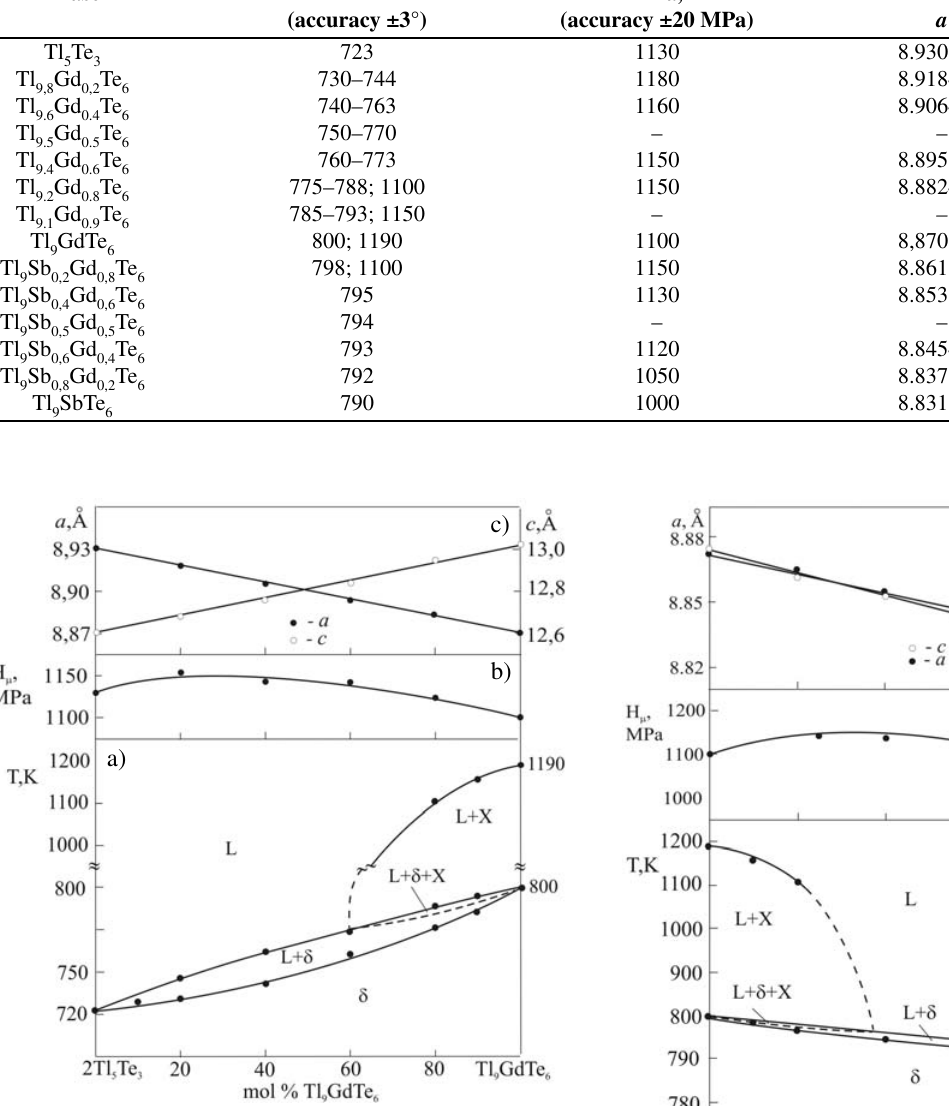
Thermal effects, Microhardness,